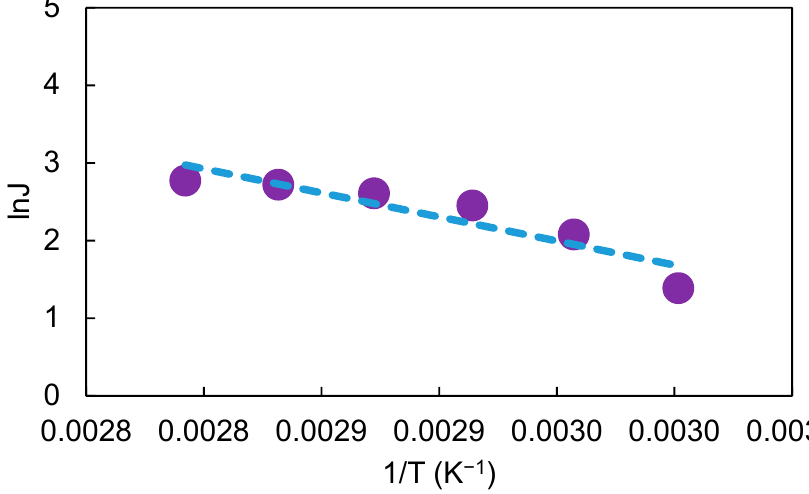
Figure4. ArrheniusplotofthewaterfluxatcrossflowReynoldsnumberof4800, feedNaClconcentration Figure 4. Arrhenius plot of the water flux at crossflow Reynolds number of 4800, feed NaCl of 15 g / L and permeate vacuum of 0.85 bar. The purple rounds represent experimental data and the concentration of 15 g/L and permeate vacuum of 0.85 bar. The purple rounds represent experimental blue dotted line is the linear regression data and the blue dotted line is the linear regression line.